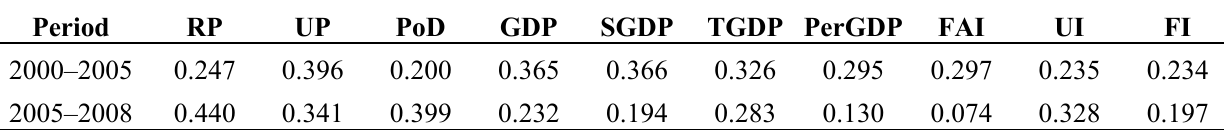
Table 8. Coefficients of the driving